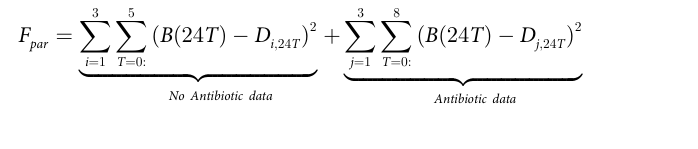
Table 1. Parameter definitions. The parameter values were those found during the optimisation process in the Results section. Parameter Definition Value Average Replication rate of